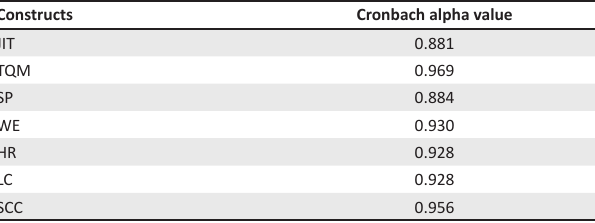
TABLE 6: Reliability results.